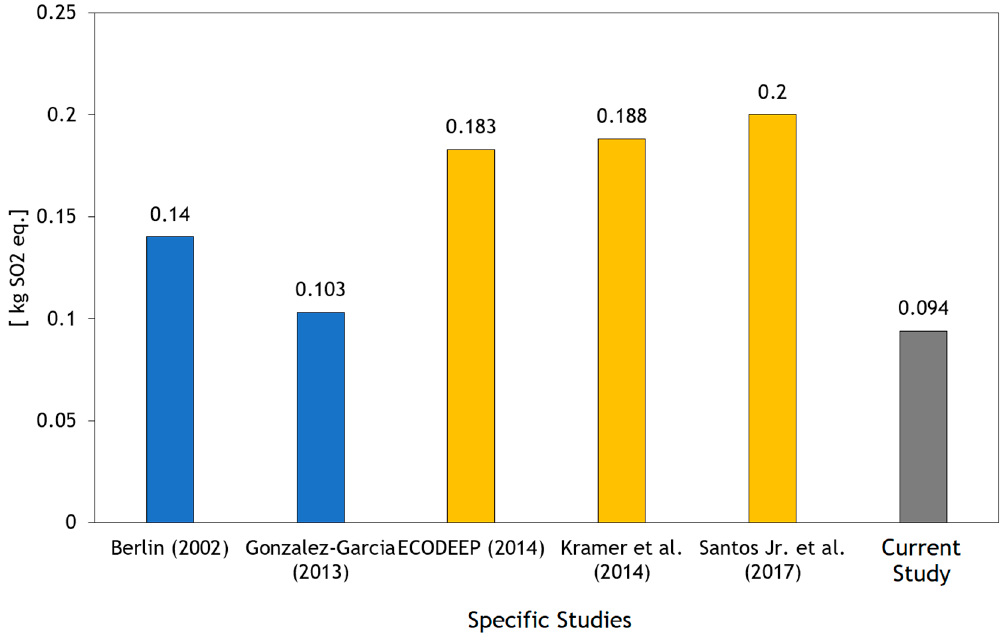
Figure 10. Terrestrial acidification results comparison with similar studies.